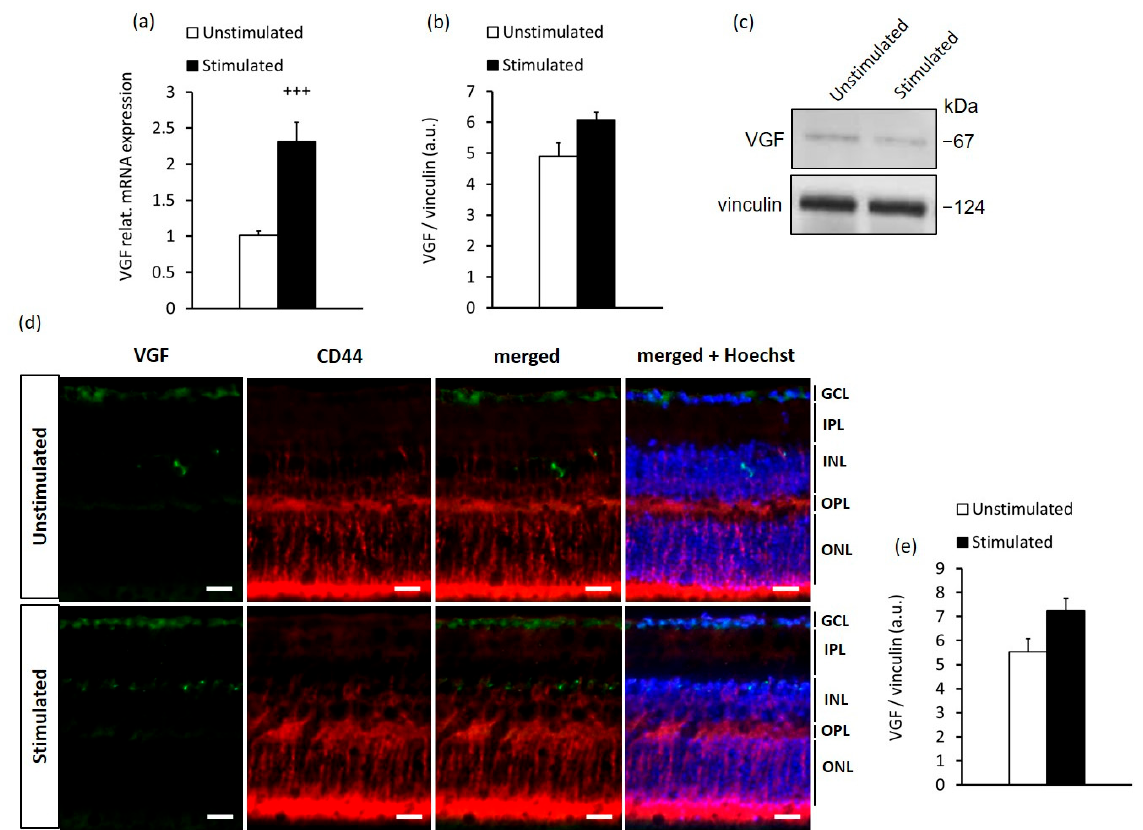
Figure 2. High-contrast stimulation increased VGF gene expression but not protein expression in the adult mouse retina. ( a ) Quantification of relative mRNA and ( b ) protein expression of VGF in the retina of high-contrast-stimulated and unstimulated mice, and ( c ) representative Western blot images from two independent experiments. ( d ) Immunofluorescence of VGF (green); CD44, a marker of MCs (red); and Hoechst nuclear staining (blue) in the retina from high-contrast-stimulated and unstimulated mice. The scale bar is 20 µ m. GCL, ganglion cell layer; IPL, inner plexiform layer; INL, inner nuclear layer; OPL, outer plexiform layer; ONL, outer nuclear layer. ( e ) Quantification of VGF immunofluorescence intensity in the retina of high-contrast-stimulated and unstimulated mice. The data are presented as the mean ± SEM of 5 mice per group in each experiment. Difference between the high contrast stimulated and unstimulated groups: +++ p < 0.001 (unpaired t -test).